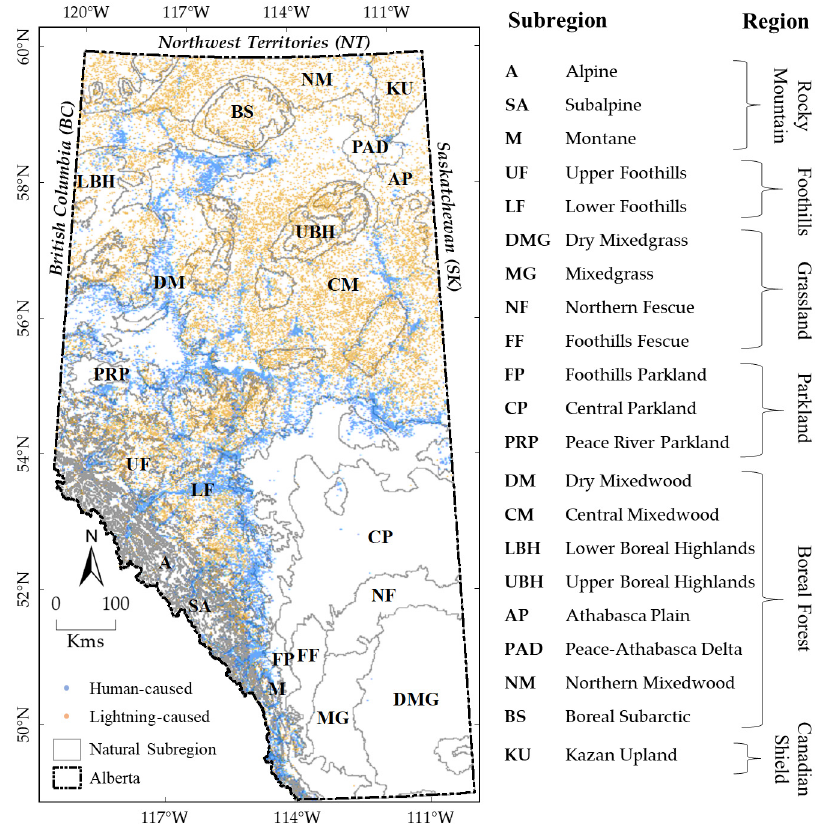
Figure 1. Study area showing the human- and lightning-caused forest fires in the natural subregions of Alberta during 1959 ‒ 2021. of Alberta during